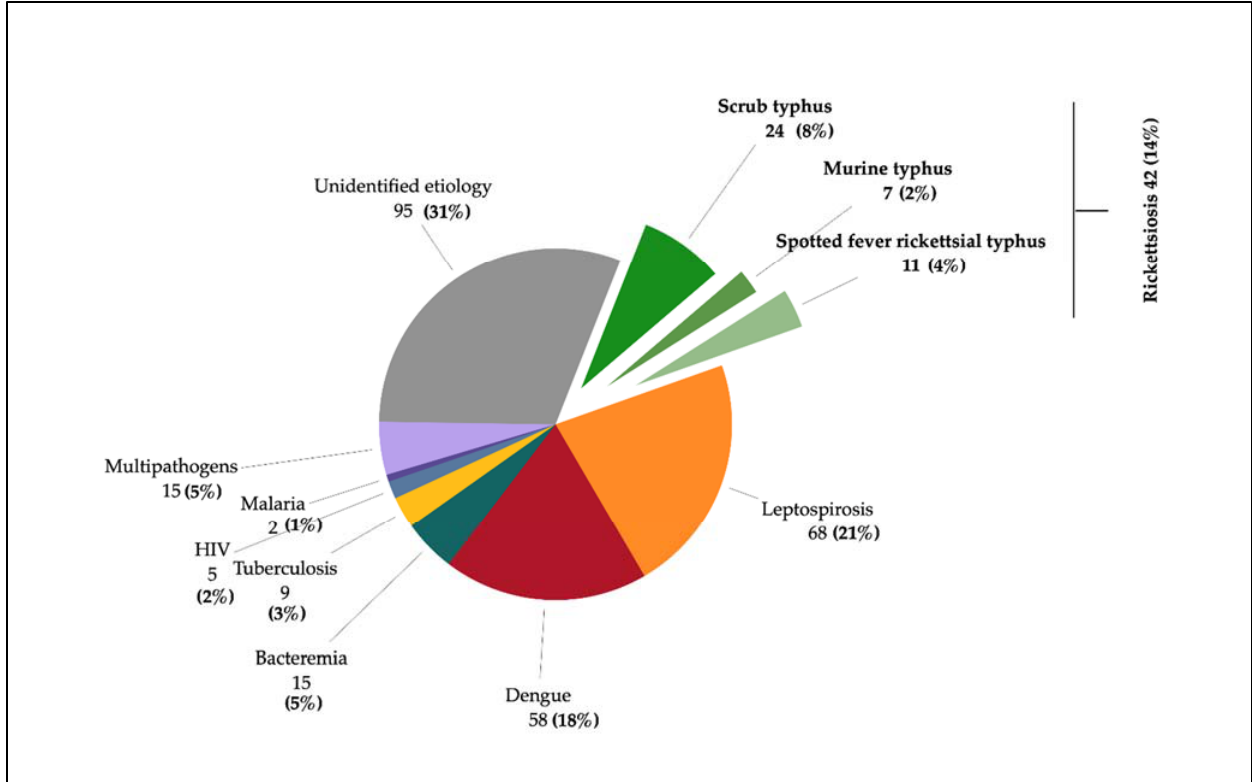
Figure 2. The etiologies of acute febrile illness in Teluk Intan from January 2016 until December 2016.